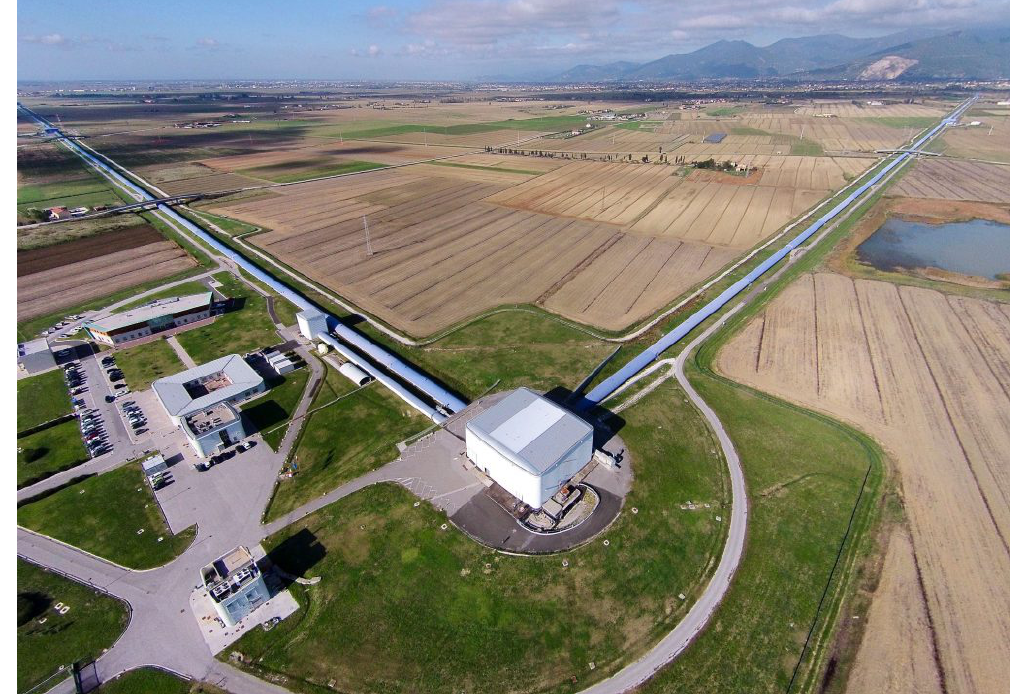
Figure 2. Aerial view of Virgo (Credits: The Virgo